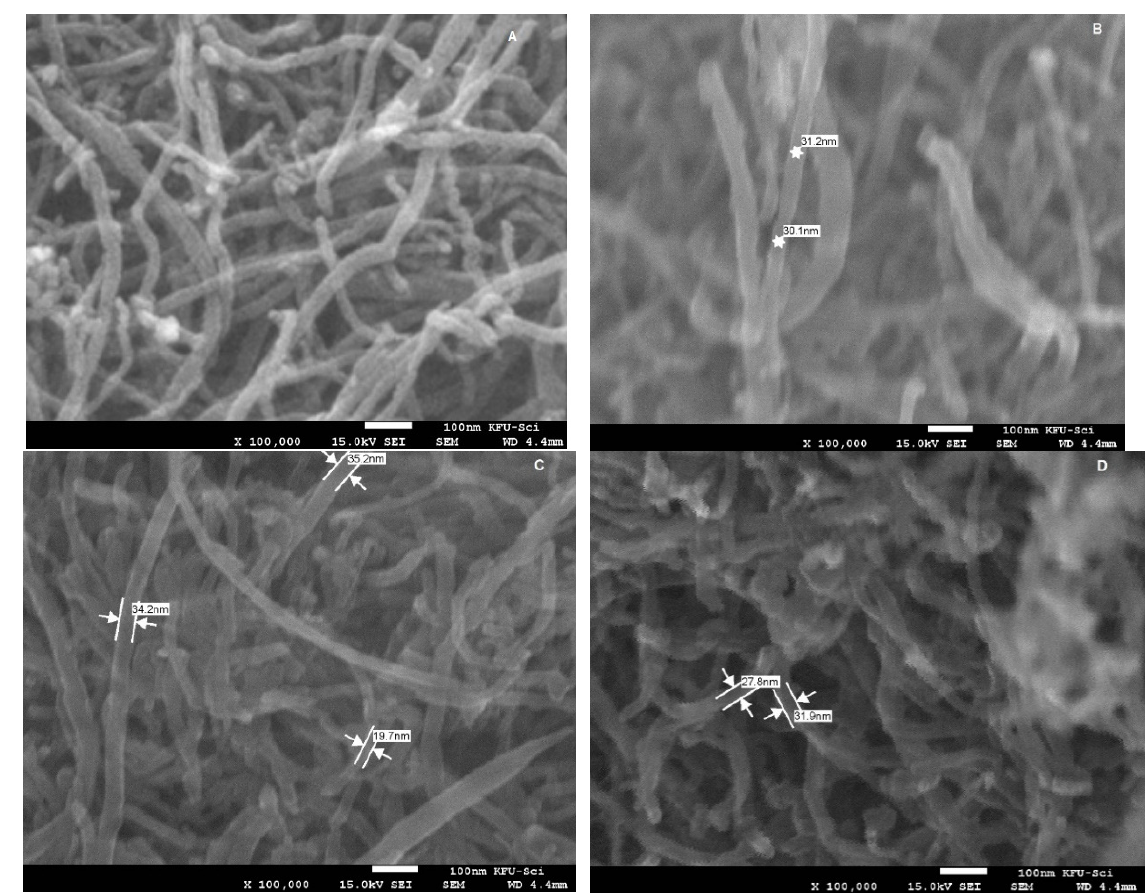
Figure 2. Scanning electron microscopy (SEM) images of ( A ) MWCNT-COOH, ( B ) MWCNT-CON- OHMe, ( C ) MWCNT-CONOHCOMe, and ( D ) MWCNT-CONOHPh. CONOHMe, ( C ) MWCNT-CONOHCOMe, and ( D )